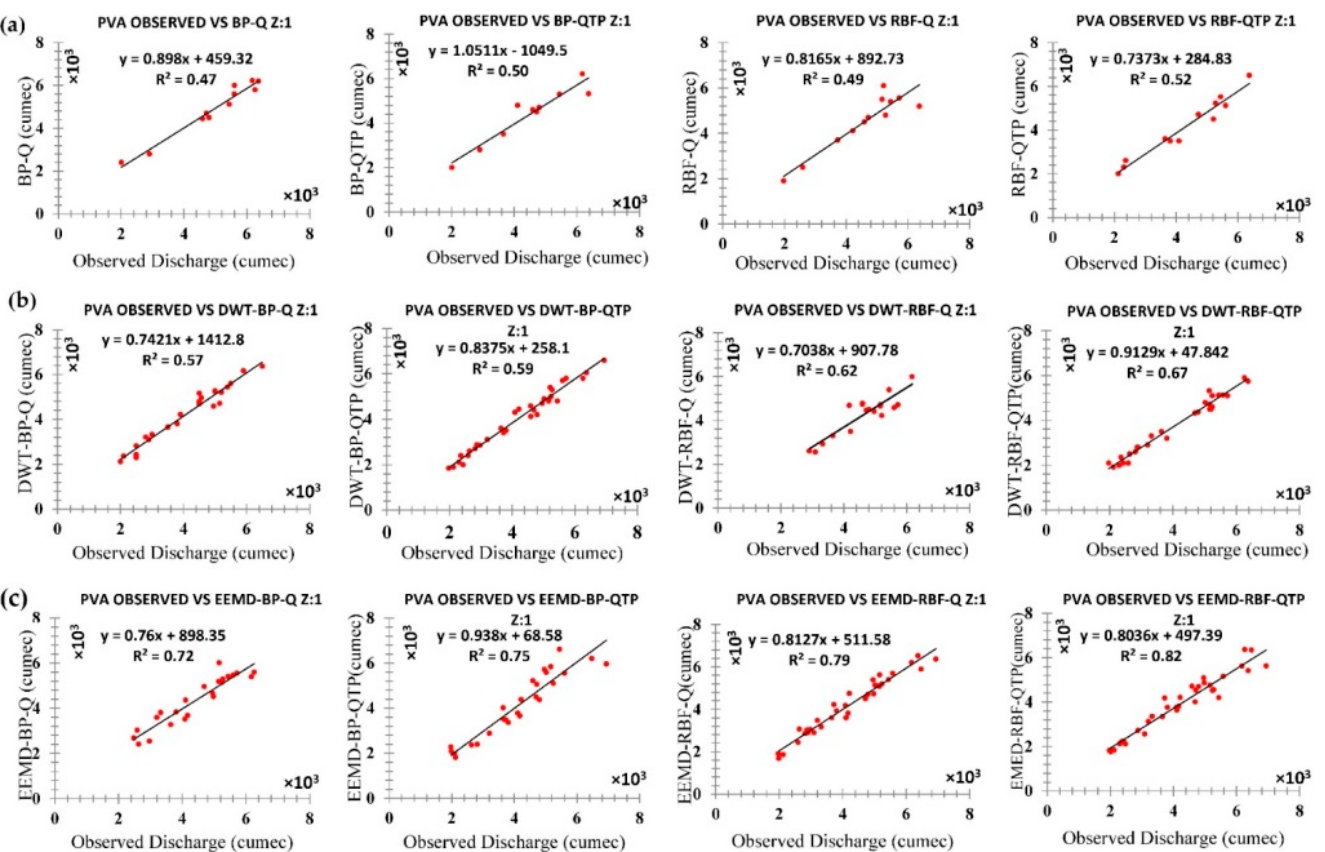
Figure 17. Monthly streamflow estimations for peak values in the flood season Zone One ( a ) OBS VS ANN (Q & QTP) Inputs, ( b ) OBS VS ANN-DWT (Q & QTP) Inputs, and ( c ) OBS VS ANN-EEMD (Q & QTP) Inputs.